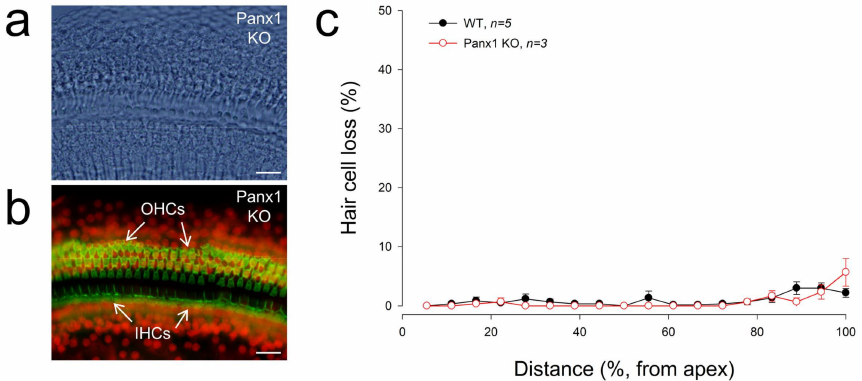
Figure 5. No apparent hair cells in Gen-Panx1 KO mice. ( a , b ): The cochlear sensory epithelia of the Gen-Panx1 KO mice in whole-mounting preparation with staining of phalloidin-Alexa Fluor-488 (green) and propidium iodide (red). OHCs: outer hair cells; IHCs: inner hair cells. Scale bars: 20 µ m. ( c ): There is no apparent hair cell loss in the Gen-Panx1 KO